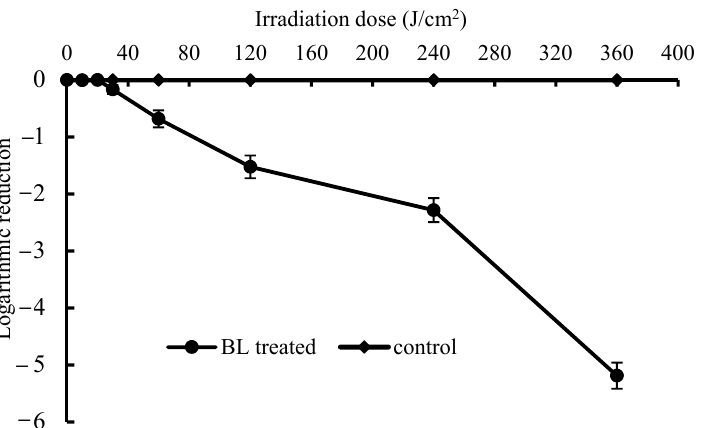
Figure 2. Light dose-dependent photodynamic inactivation of S . Enteritidis in vitro . Error bars represent the standard deviation of three separate experiments.